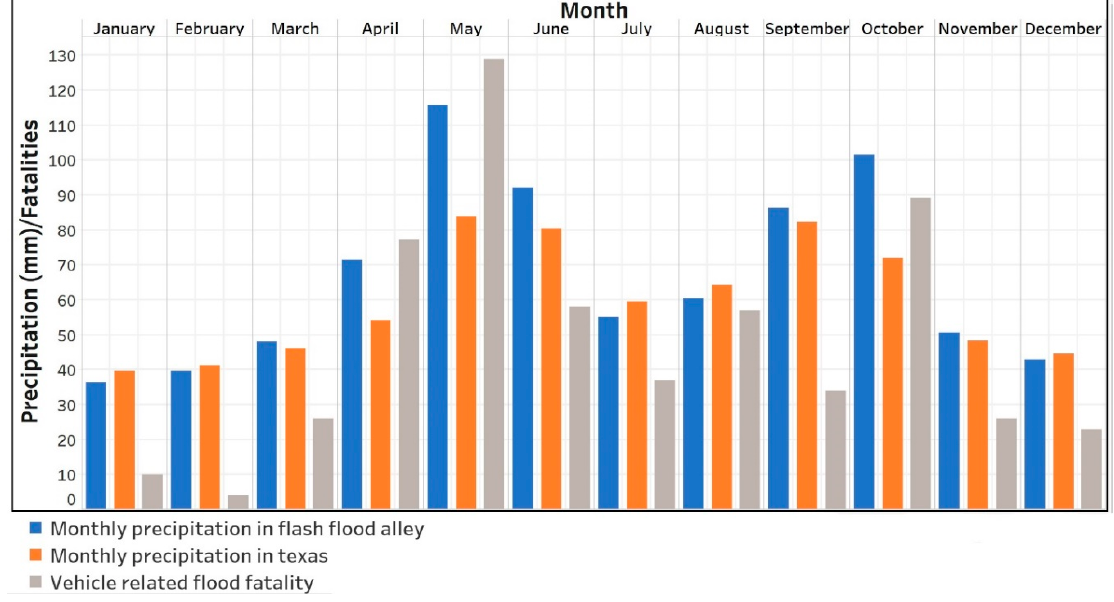
Figure 5. Monthly distribution of vehicle-related flood fatalities and average monthly precipitation in Flash Flood Alley and average monthly precipitation in Texas, 1959–2019.